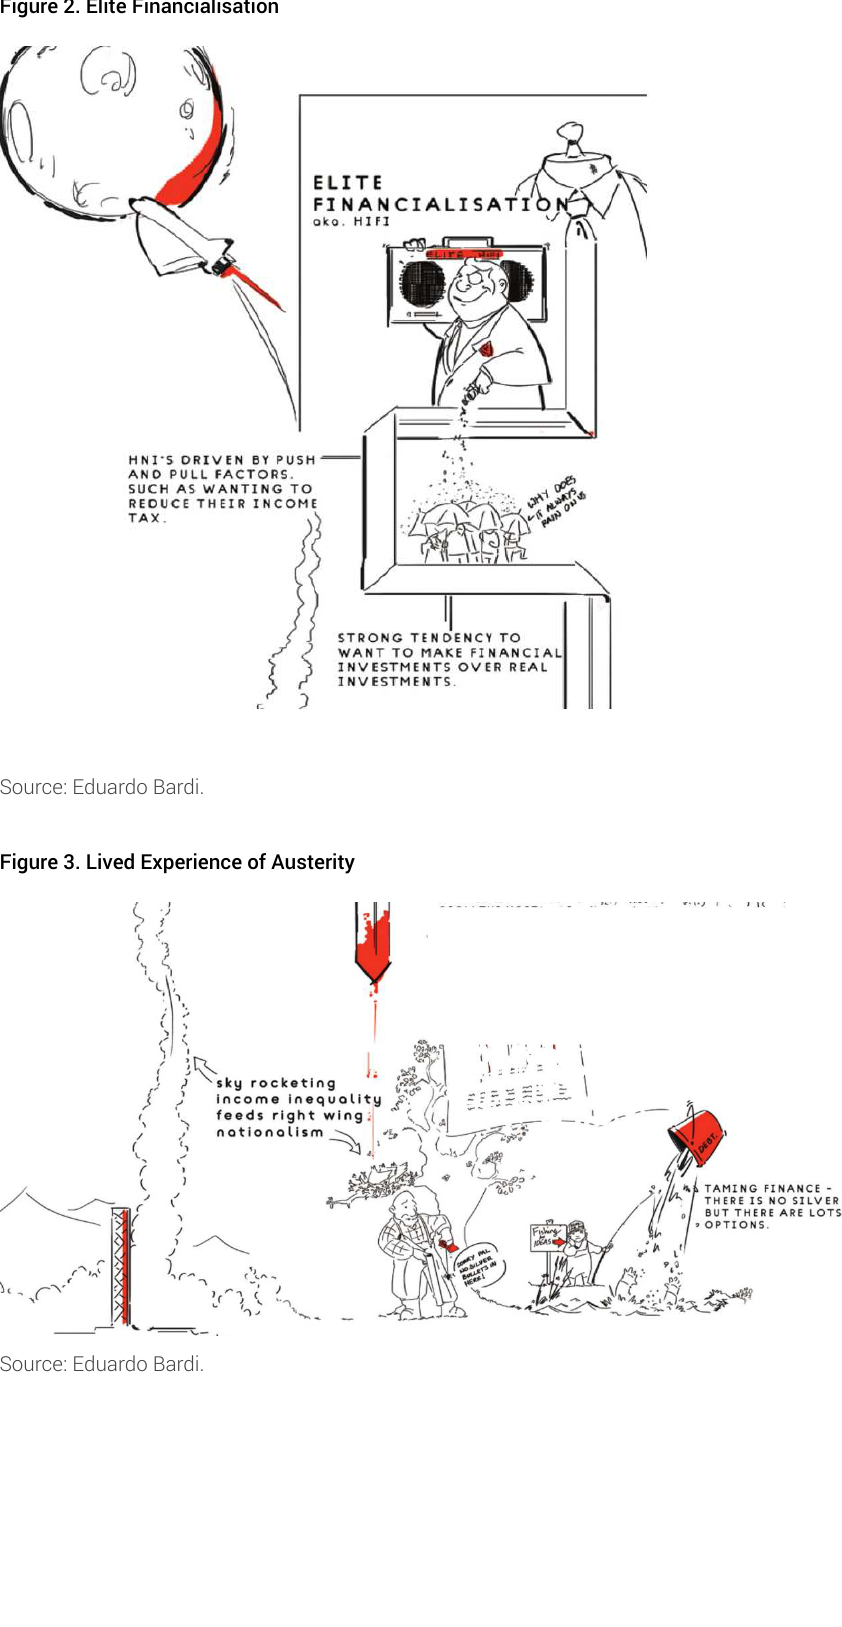
Figure 2. Elite Financialisation